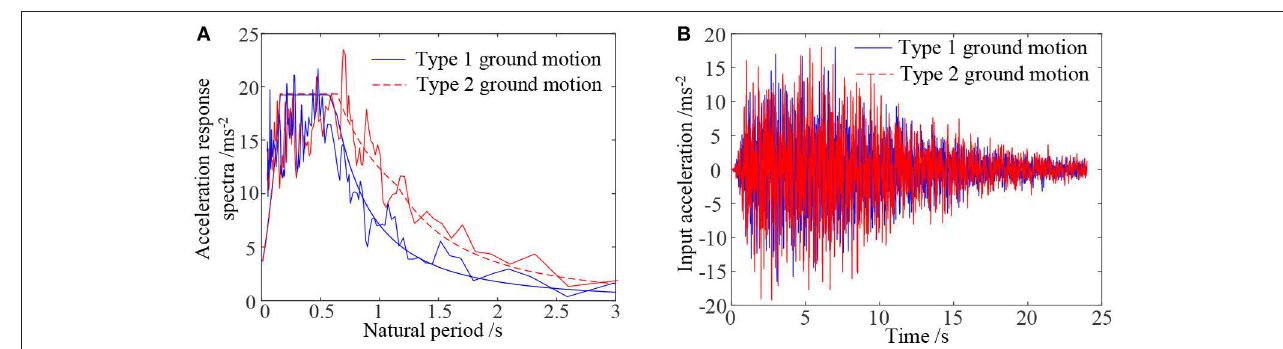
FIGURE 5 | The response spectra and corresponding time histories of seismic ground motions. (A) The response spectra of ground motions. (B) Scaled seismic ground motions.